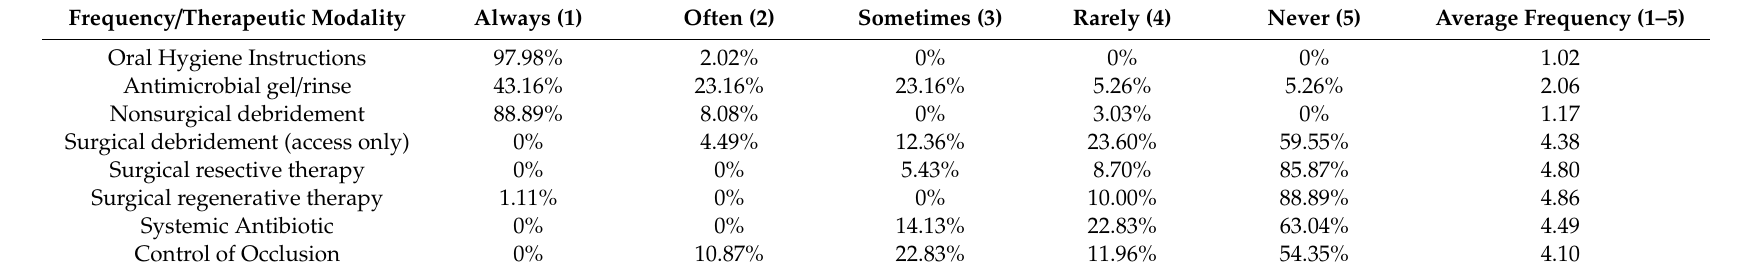
Table 4. Peri-implant Mucositis Treatment Modalities: Average Frequency (Always (1) through to Never (5)).